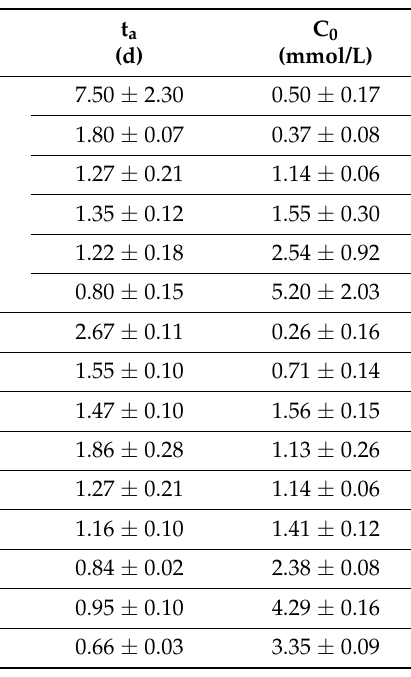
Figure 3. Relative released L-leucine concentration (i.e., actual concentration relative to the expected concentration upon homogeneous distribution over the combined aqueous phases) in the external phase as a function of storage time at 4 °C of double emulsions containing 5 mmol/L (diamonds), 10 mmol/L (circles), 20 mmol/L (triangles) or 40 mmol/L (squares) leucine prepared with HOSO at pH 7. Table 2. Estimated average residence time (t a ) and initial concentration in the external aqueous phase (C 0 ) (with 95% confidence interval) of amino acids and di-peptides in double emulsions prepared with HOSO as a function of the average solute concentration in the aqueous phase and the aqueous phase pH, during storage at 37 ◦